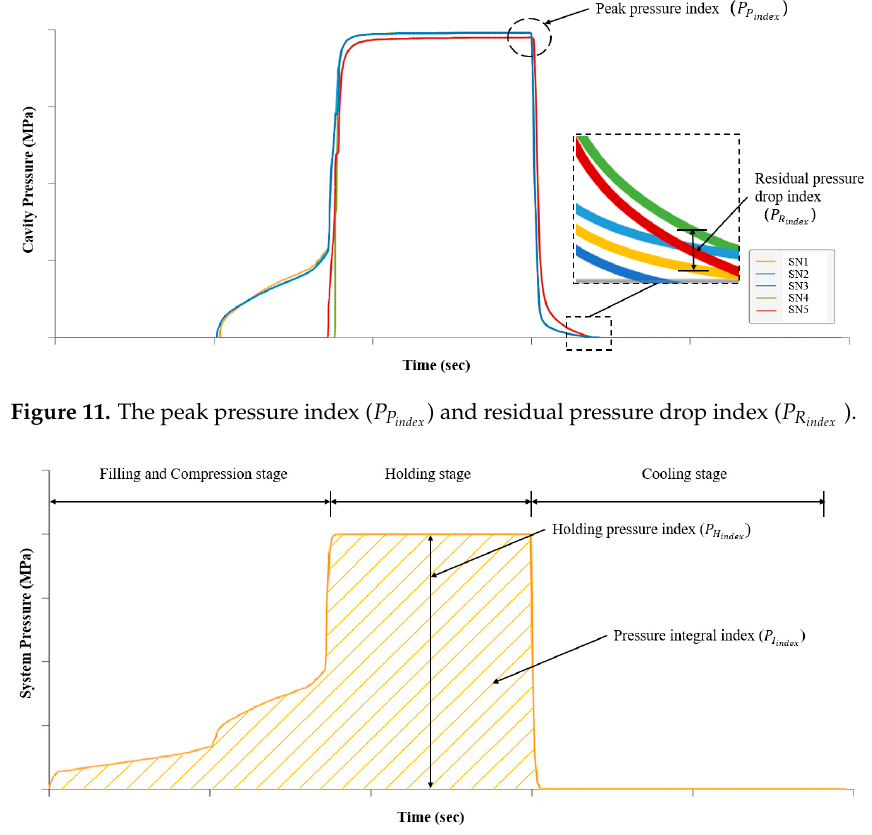
Figure 12. The pressure integral index ( 𝑃 (cid:3010)